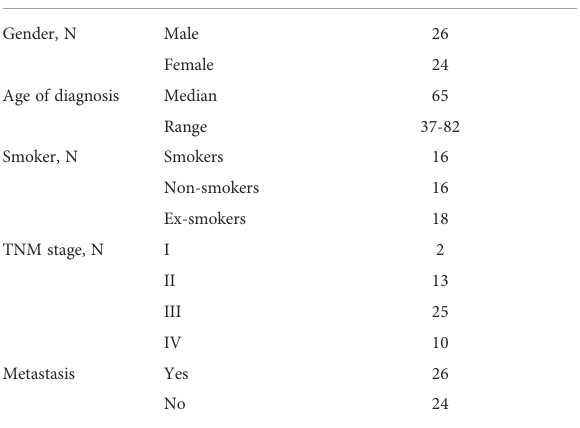
TABLE 1 Patients ’